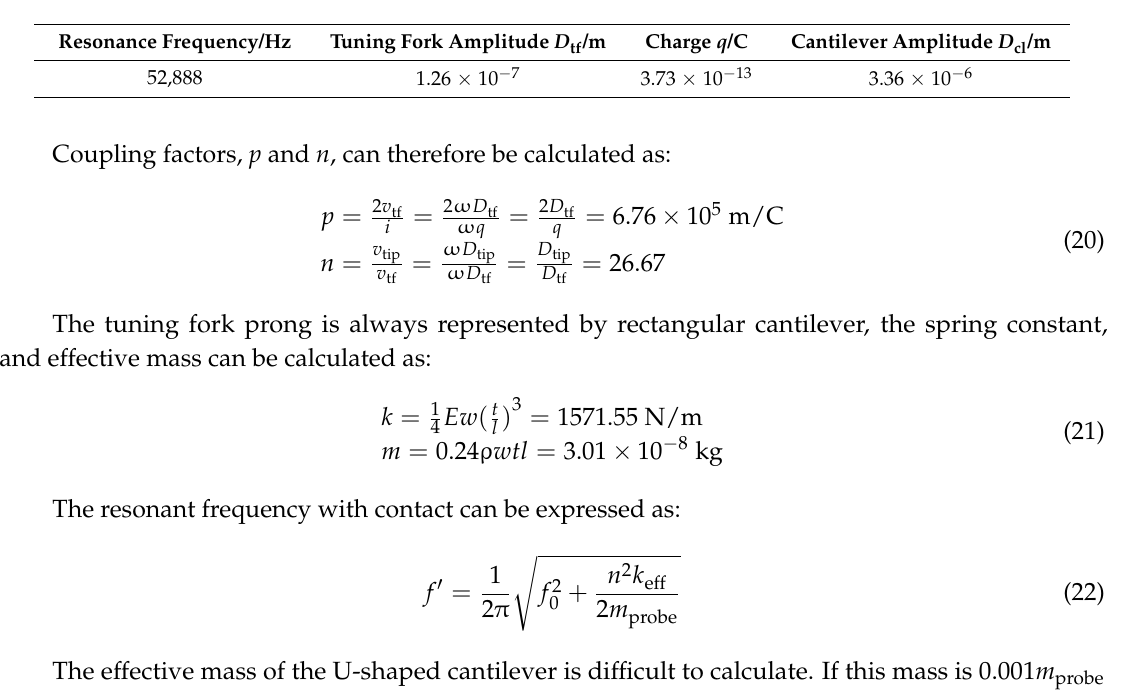
Table 3. The results of ANSYS